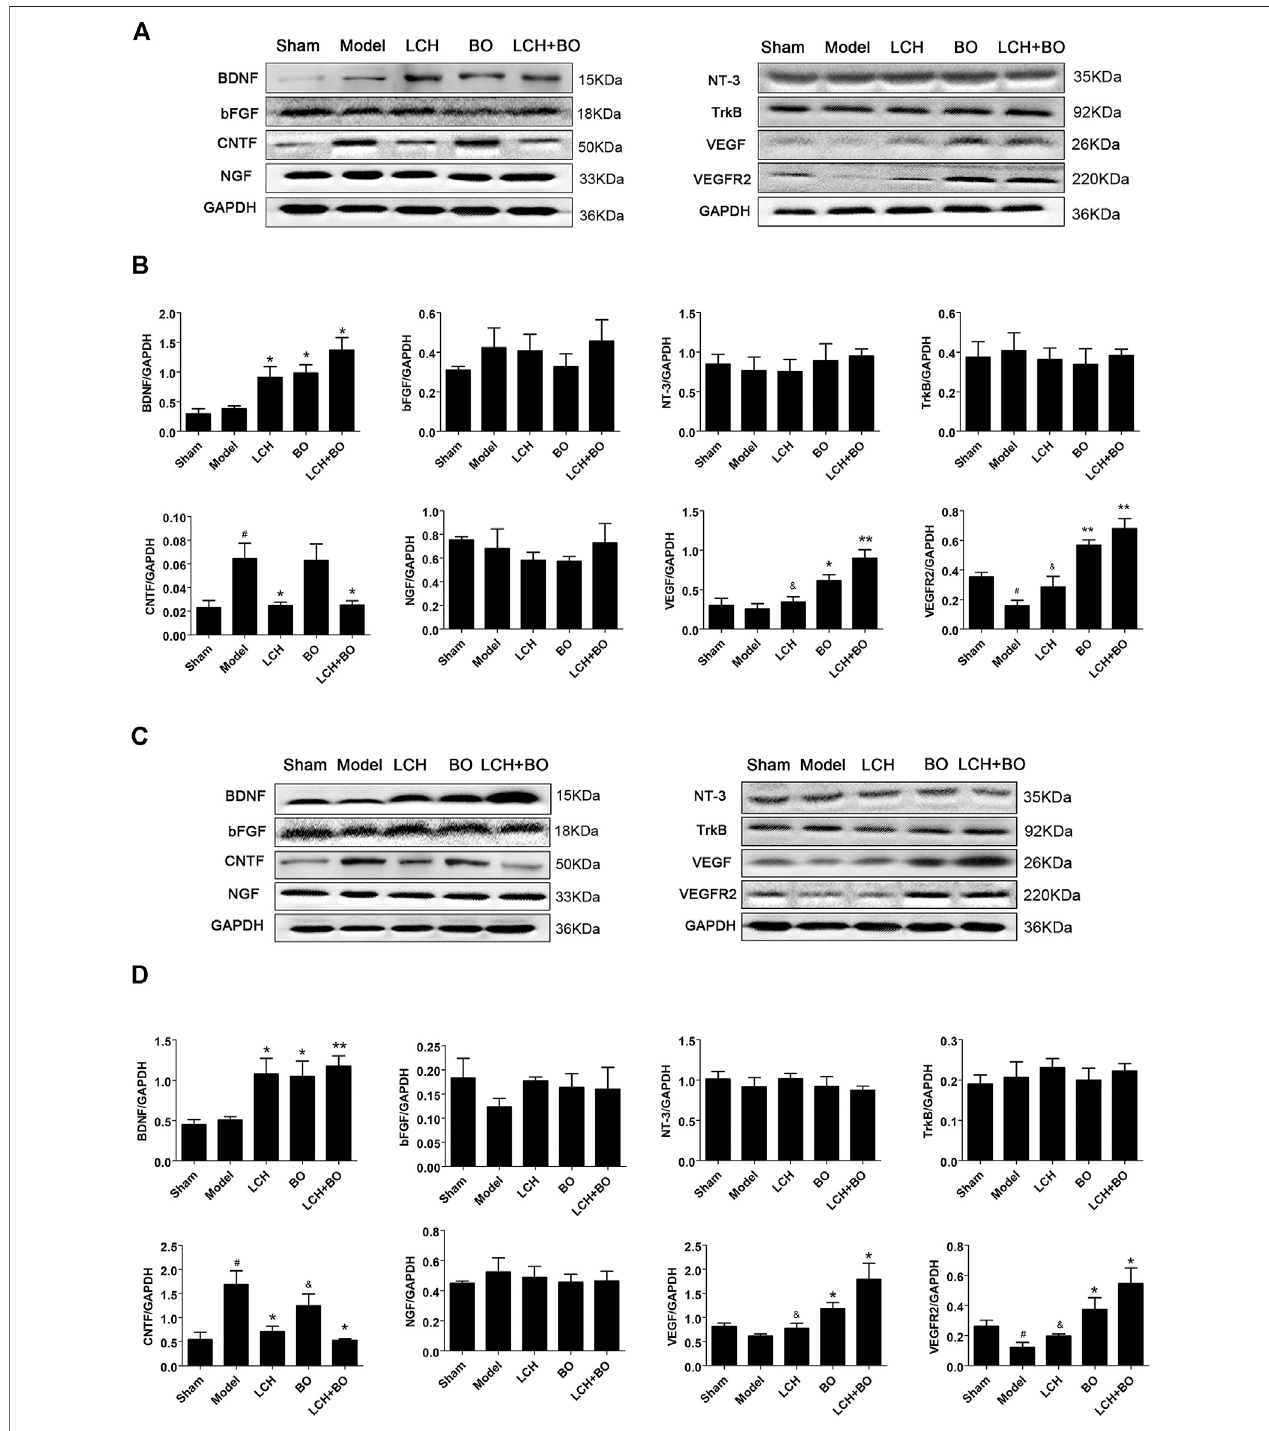
FIGURE14| ExpressionsofBDNF,bFGF,CNTF,NGF,NT-3,TrkB,VEGF,andVEGFR2withinDGandSVZofMCAOrats. (A) BlotimagesoftheproteinsintheDG area. (B) Relative expression of the proteins to GAPDH in the DG area ( n (cid:1) 3). (C) Blot images of the proteins in the SVZ area. (D) Relative expressions of the proteins to GAPDHintheSVZarea( n (cid:1) 3). # p < 0.05comparedtotheshamgroup;* p < 0.05, ** p < 0.01comparedtothemodelgroup; & p < 0.05comparedtotheLCH+BOgroup.